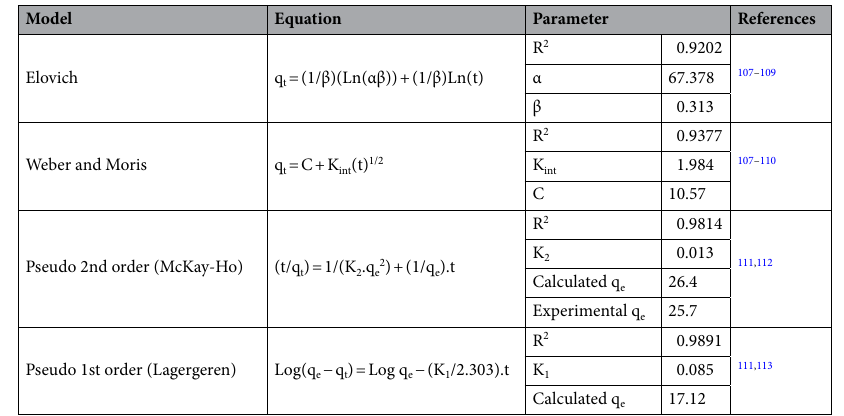
Table 6. Equations of adsorption kinetic models for naproxen adsorption on ZrO 2 /TiO 2 /Fe 3 O 4 nanocomposite. q